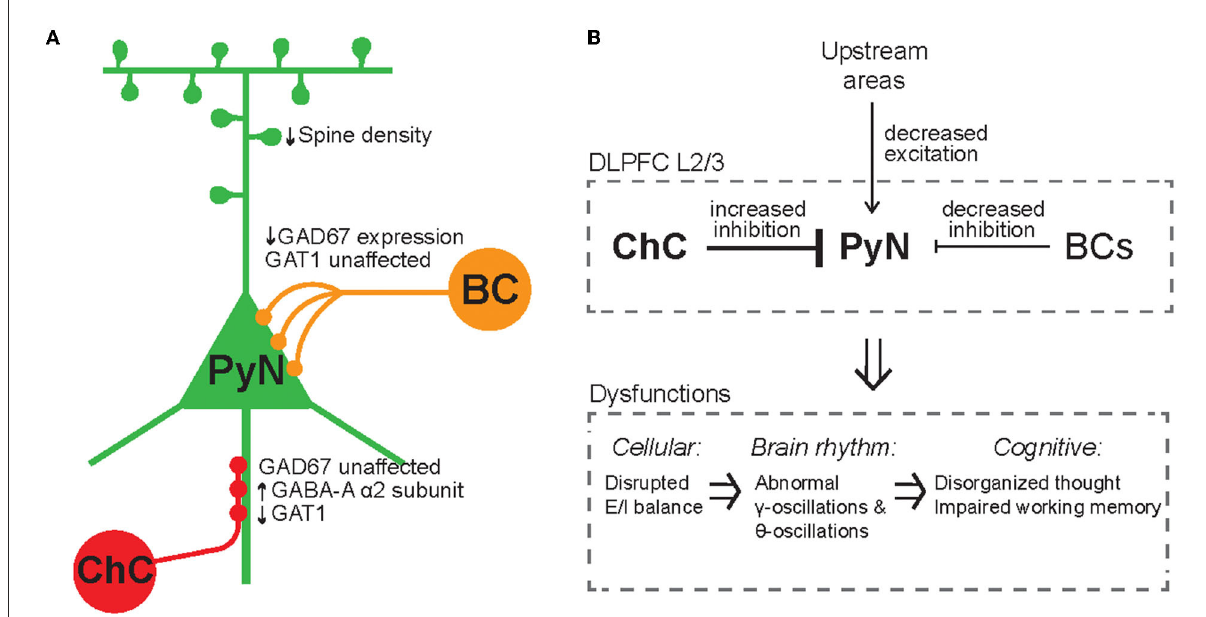
FIGURE5 Synaptic alterations of ChCs, BCs, and PyNs in schizophrenia. (A) Schematic of molecular and cellular alterations of ChCs, BCs, and PyNs in schizophrenia. In ChCs, GAD67 levels in terminals are unaffected, post-synaptic GABA-A α 2-subunit receptor density is increased, pre-synaptic GAT1 density is reduced, and ChC cartridge density increases. ChC-related alterations correspond to an increase in inhibition on PyNs. In BCs, GAT67 levels are decreased, suggesting a decrease of BC-mediated inhibition on PyNs. In PyNs, dendritic spine density is reduced, resulting in lower levels of excitatory drive. (B) GABAergic interneuron-related pathophysiology in schizophrenia. ChC-related alterations reflect an increased inhibition on PyNs, and PyNs receive lower levels of excitatory drive from upstream areas, resulting in reduced excitability of PyNs and disruption of E/I balance. BC-related alterations reflect a decrease in inhibition on